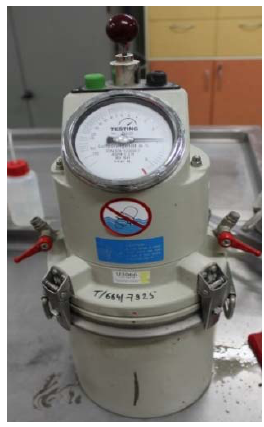
Figure 1. Measurement of the air content in a concrete mixture.